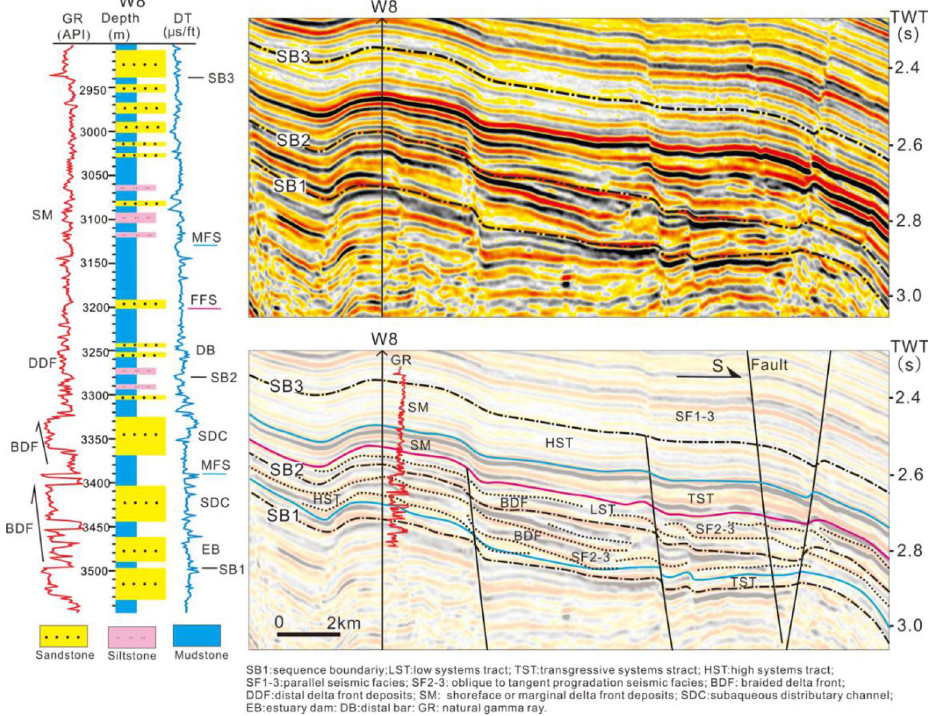
Figure 4. An interpreted seismic profile calibrated to borehole W8 showing the deposits of the braided river delta front at S1 in the northwest Baiyun Sag (see Fig. 1b for location of the profile). The deltaic deposits have characteristic thick bedded foresets with an upward-coarsening grain-size (borehole W8 log